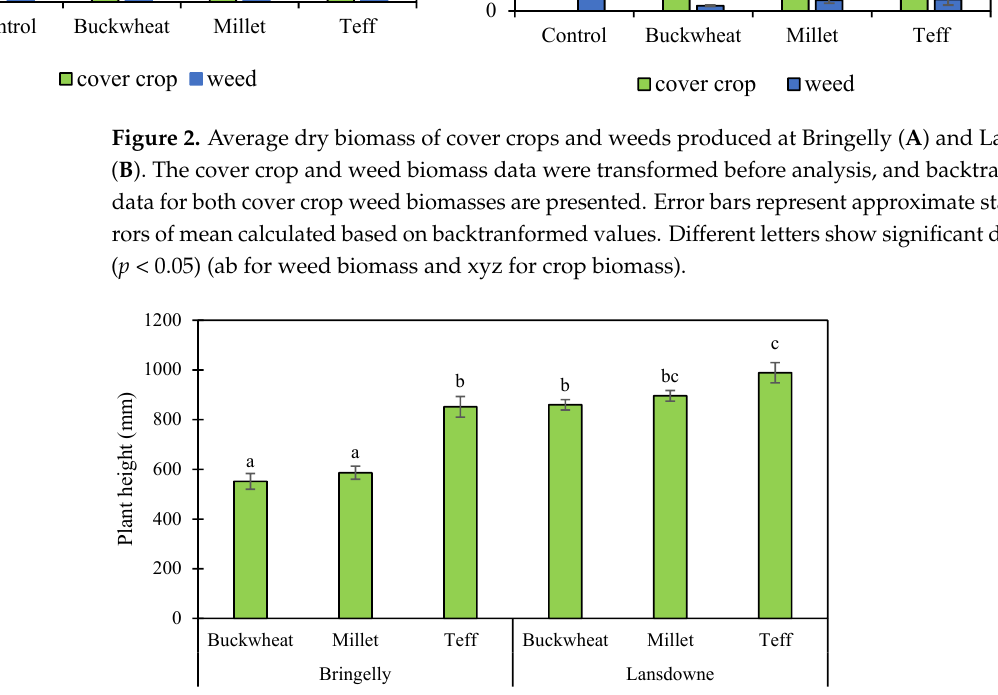
Figure 3. Average crop heights at Bringelly and Lansdowne. Error bars show standard errors of the mean of four replicates. Different letters show significant differences ( p < 0.05) between cover crop treatments at each site.